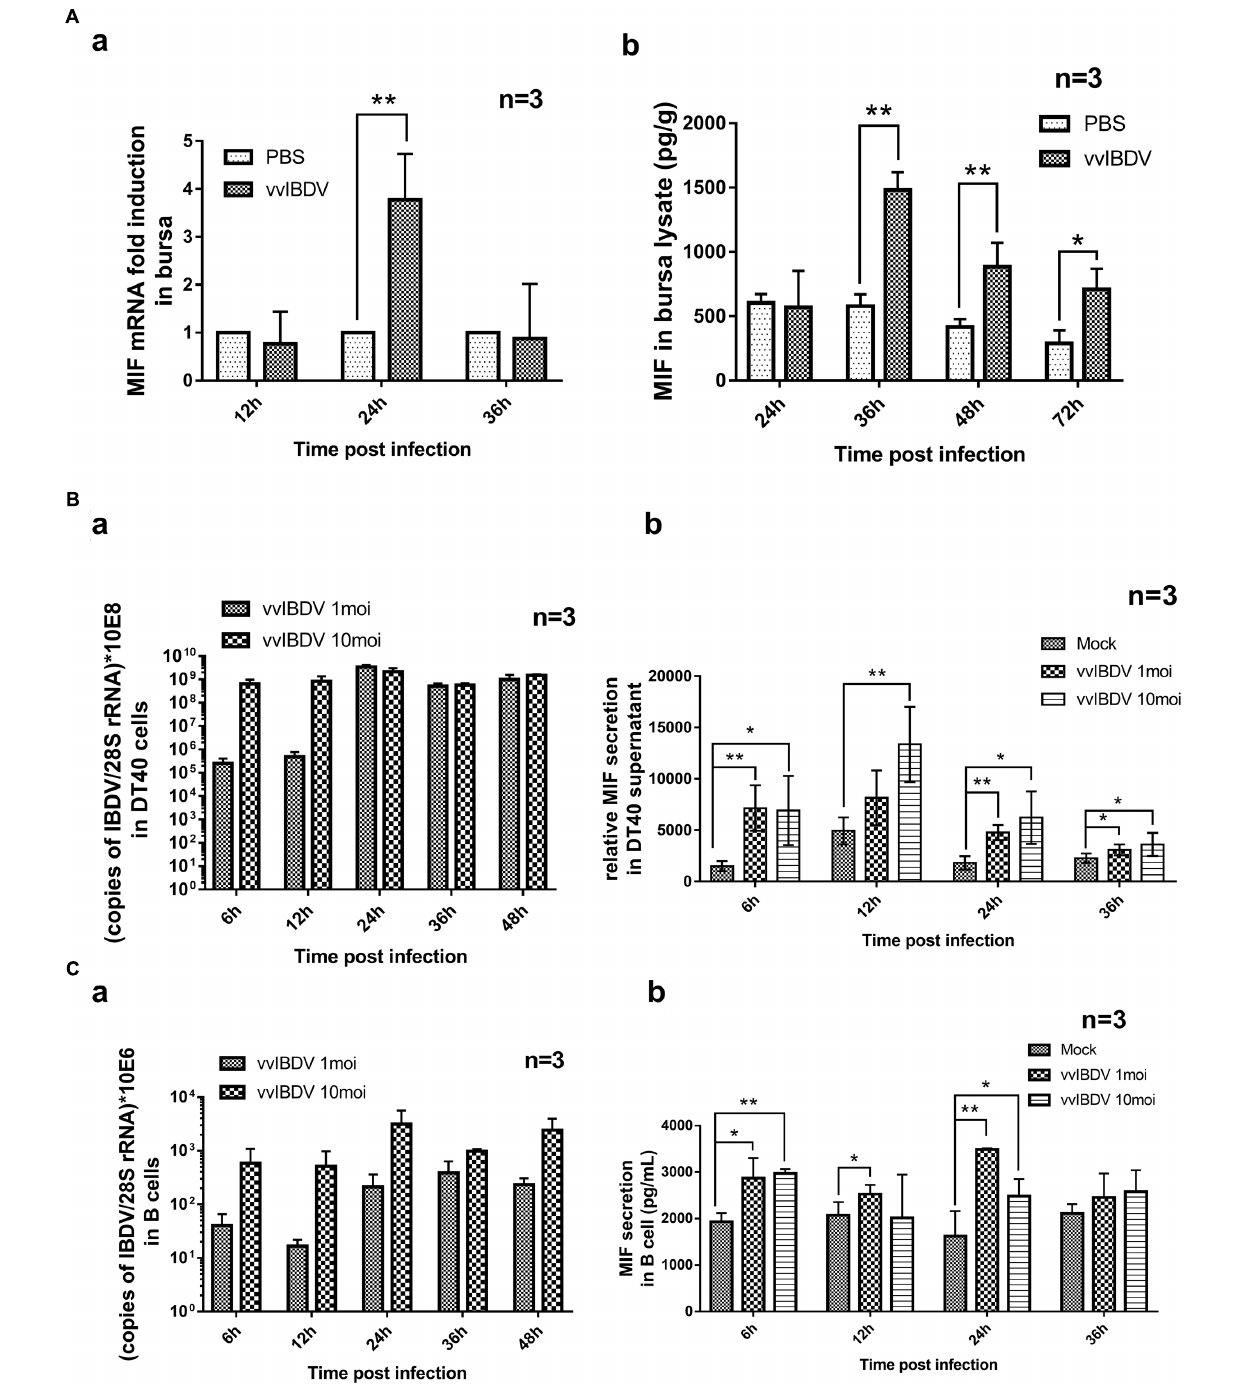
FIGURE 3 | Chicken macrophage migration inhibitory factor (chMIF) was upregulated in response to very virulent infectious bursal disease virus (vvIBDV) infection both in vivo and in vitro. (A) The bursas from vvIBDV-infected animals were analyzed for chMIF transcription or expression analysis. (a) The transcription level of chMIF at 24 h.p.i. (b) Enzyme-linked immunosorbent assay (ELISA) of bursal lysis samples to assess the expression of chMIF in response to IBDV infection. ∗ P < 0.05 and ∗∗ P < 0.01 compared with control groups. (B) DT40 cells were infected with 1 and 10 multiplicity of infection (MOI) of vvIBDV, and cells and supernatants were collected for quantitative polymerase chain reaction (qPCR) and ELISA. (a) Replication of vvIBDV in DT40 cells. (b) Secretion of chMIF in vvIBDV-infected groups, as detected by ELISA. (C) Bursal cells were infected with 1 and 10 MOI of vvIBDV, and cells and supernatants were collected for qPCR and ELISA. (a) Replication of vvIBDV in primary bursal cells. (b) Secretion of chMIF in vvIBDV-infected groups, as detected by ELISA. ∗ P < 0.05 and ∗∗ P < 0.01 compared with control groups.